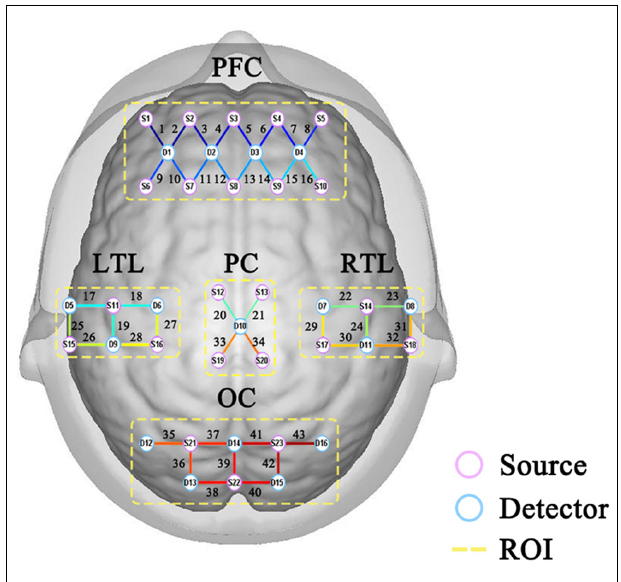
FIGURE 2 | Distribution of channels.